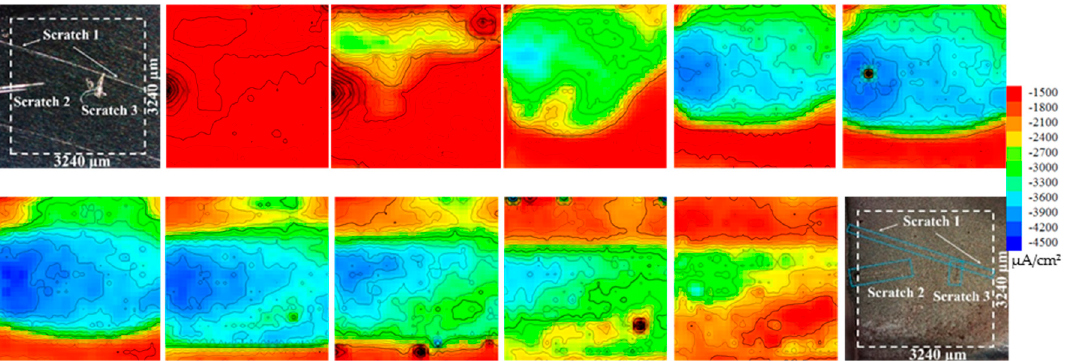
Figure 5. Corrosion progress of sample in NaCl solution measured by scanning vibrating electrode technique (SVET) test.